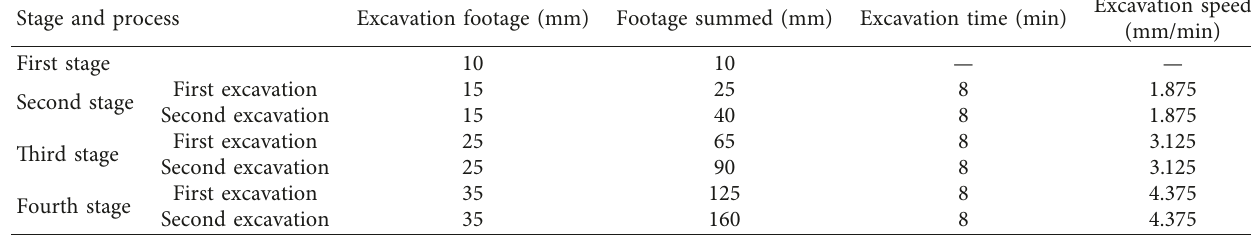
Table 1: Excavation load.